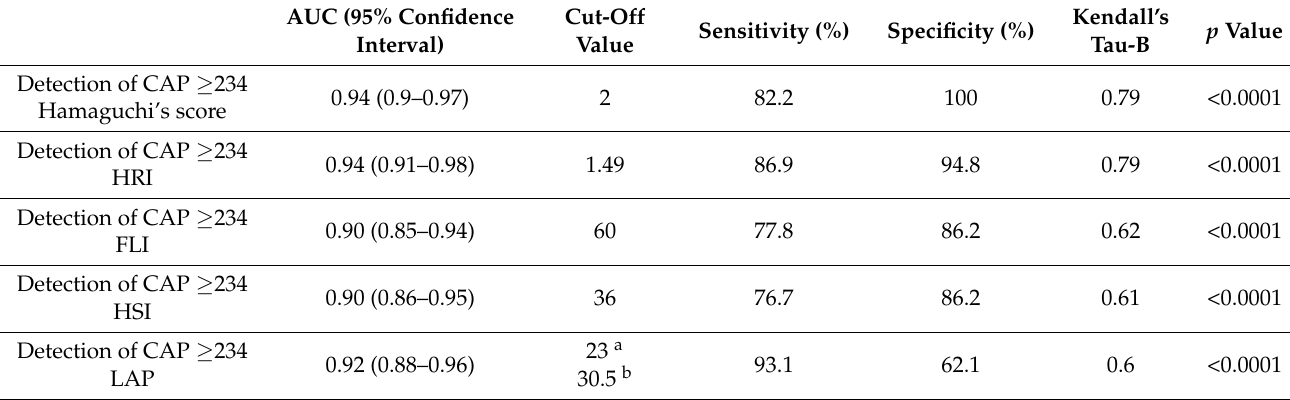
Table 2. Diagnostic accuracy of Hamaguchi’s score, HRI, FLI, HSI, and LAP for the detection of hepatic